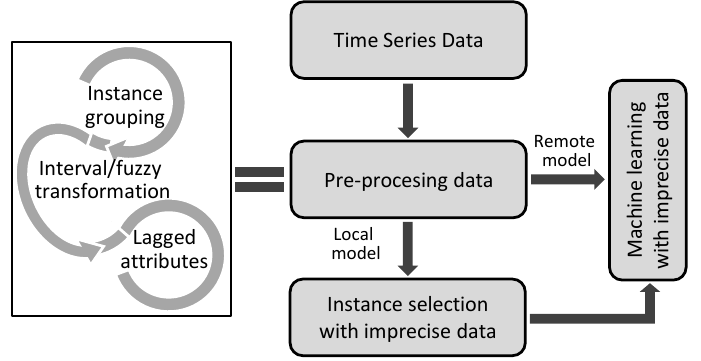
Figure 2. Diagram of preprocessing and model